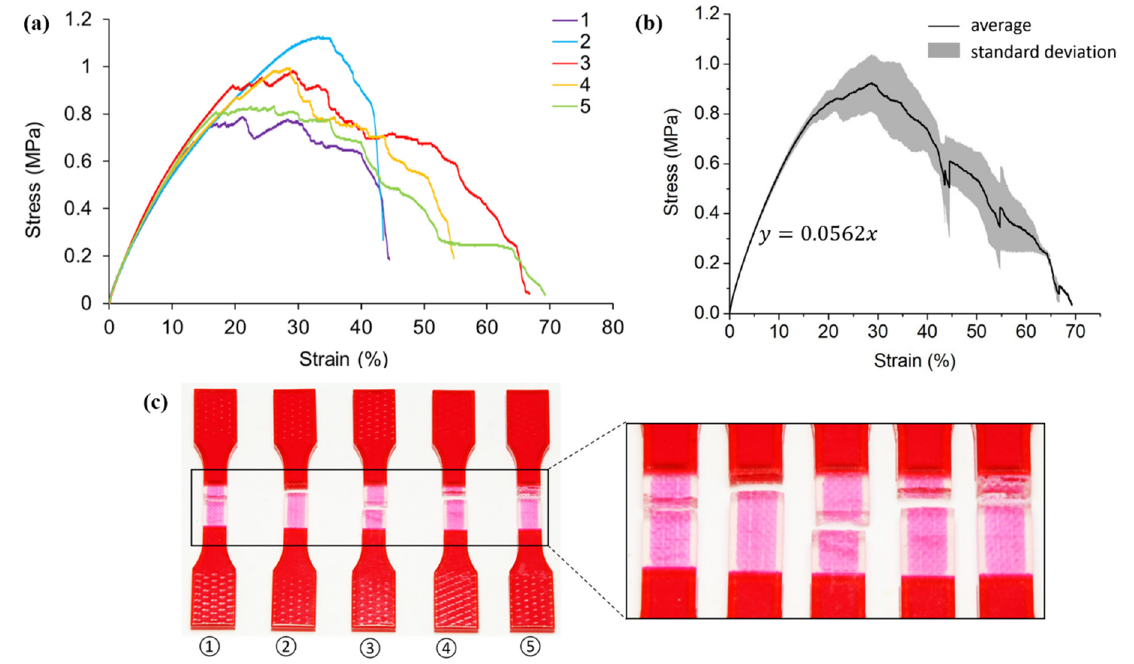
Figure 8. ( a ) Stress-strain curves obtained from tensile testing tests on hybrid case four (pure vertical second order) samples; ( b ) average tensile stress-strain curve and standard deviation of all five testings; ( c ) pictures of failed tensile samples with zoom-in at the locations of fracture.